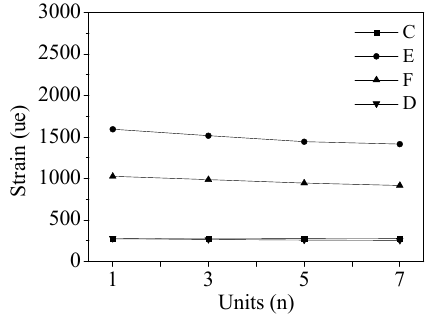
ff ect of the number of ring units on the strain Figure 11. Effect of the number of ring units on the strain results. Figure 11. E Figure 11. Effect of the number of ring units on the strain results.